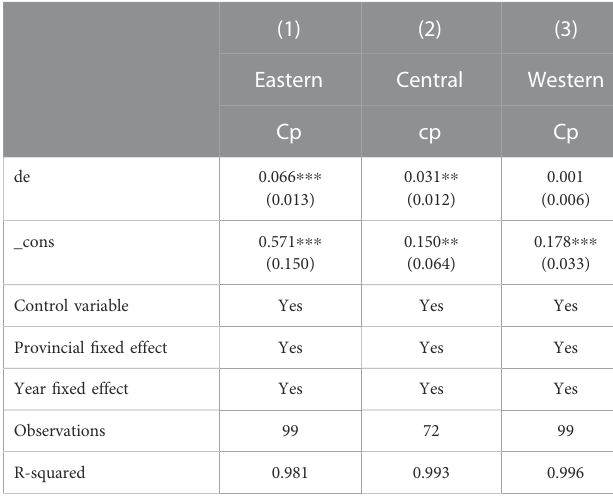
TABLE 9 Heterogeneity